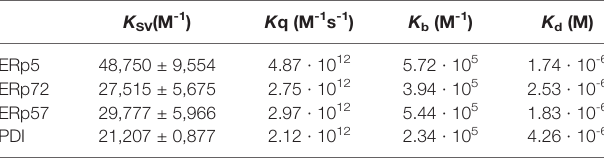
TABLE 1 | Constants calculations based on protein quenching studies.